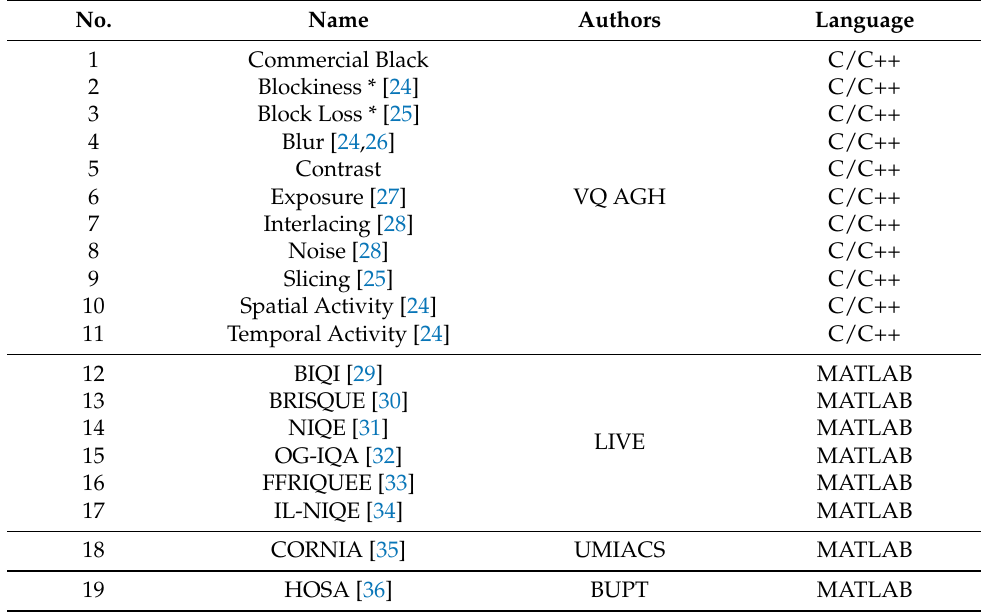
Table 3. The list of Video Quality Indicators (VQIs) to be used in the quality experiment. Indicators marked with an asterisk (*) are not directly in line with the scope of the project.